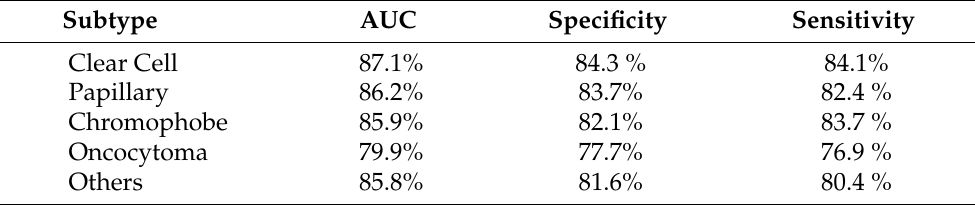
Table 2. Quantification results of renal mass subtype classification on KiTs19 datasets.